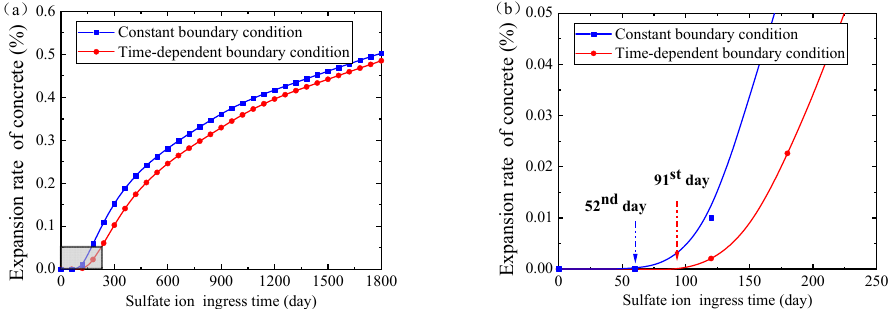
Figure 18. ( a ) History curves of concrete expansion rate along with sulfate ingress time, and ( b ) a local enlargement.